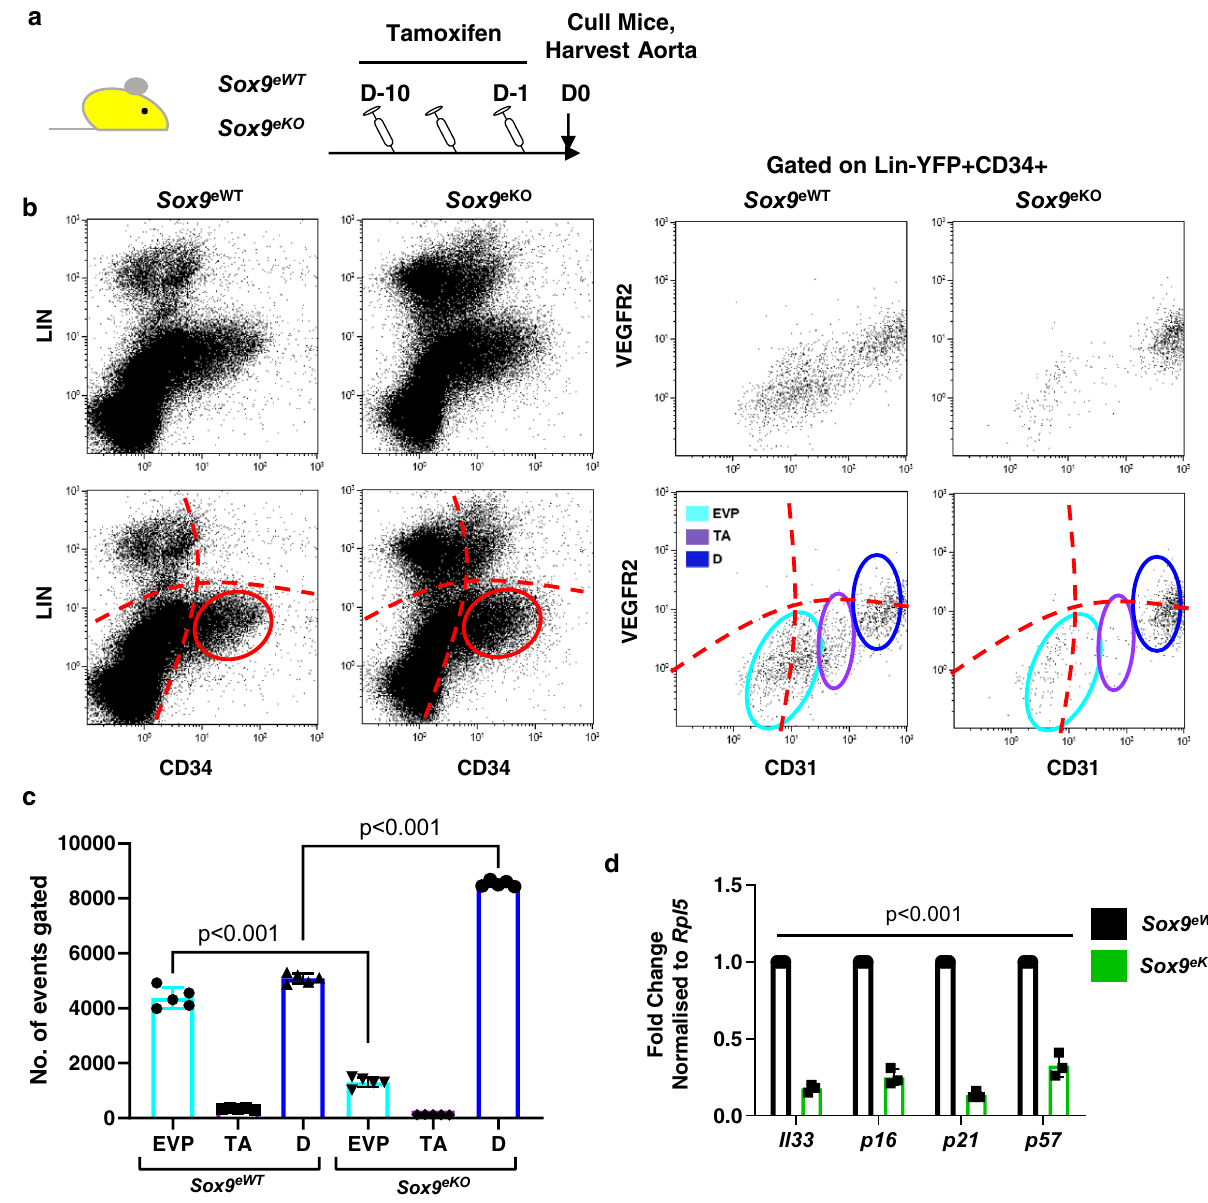
Fig. 2 SOX9 expression is essential for endovascular progenitor clonogenicity and quiescence. a Schematic diagram demonstrating experimental set up using conditional vascular speci fi c Sox9 knockout mice ( Sox9 fl / fl /Cdh5-Cre ER RosaYFP – Sox9 eKO ) and sample collection 12 weeks post-induction. b Flow cytometry plots showing the aortic endothelium harbour a distinct CD34 positive, lineage (Lin) negative population (red gate) that is entirely YFP positive, as determine by fl uorescence minus one (FMO) analysis. Three distinct populations were observed based on CD31 and VEGFR2 expression (from left to right endovascular progenitor EVP; transit amplifying TA; differentiated D) showing the endothelial hierarchy and changes between wild-type controls ( Sox9 eWT ) and Sox9 eKO mice after 10 days tamoxifen. c Number of EVP is signi fi cantly reduced in Sox9 eKO ( p < 0.001 vs Sox9 eWT ; n = 3 biologically independent animals; mean ± SD). d qPCR analysis of genes associated with endothelial quiescence in EVP (*** p < 0.001 vs Sox9 eWT ; n = 3; mean ±